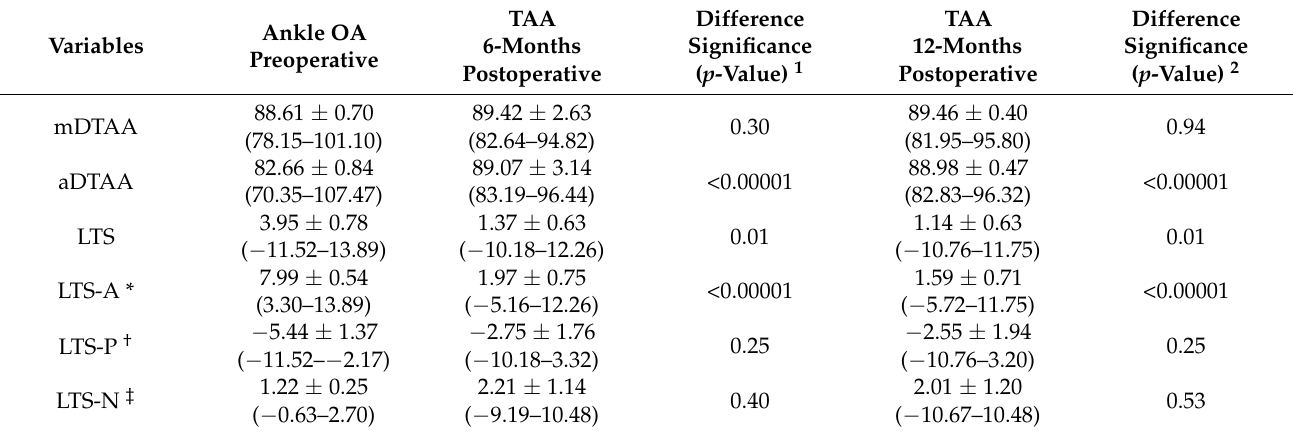
Table 3. Radiological